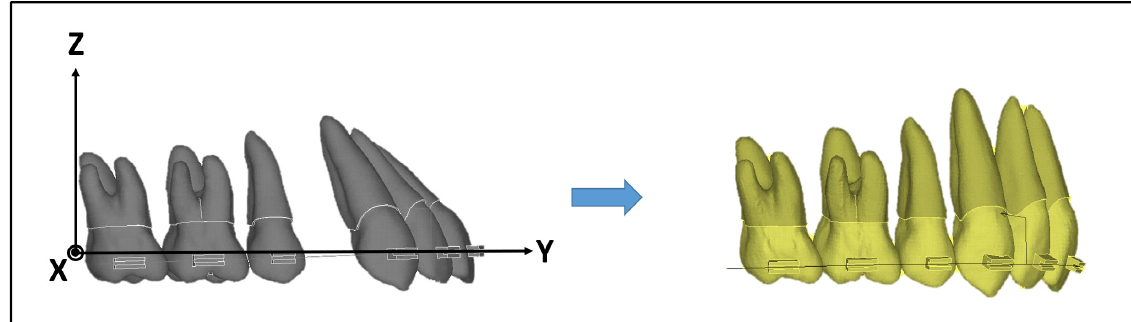
Figure 10. Tooth movement of posterior and anterior teeth after space closing in LOMS3.